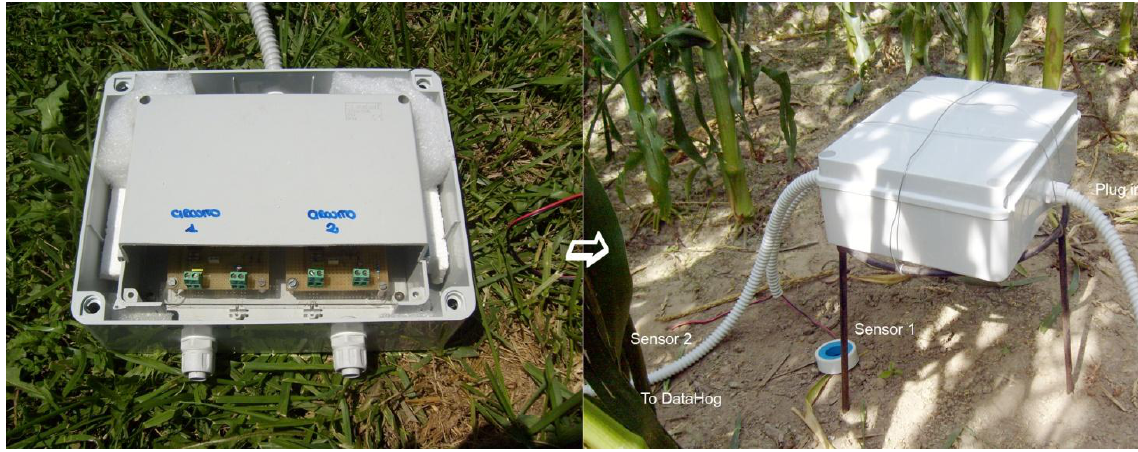
Figure 5. Field soil water content measuring